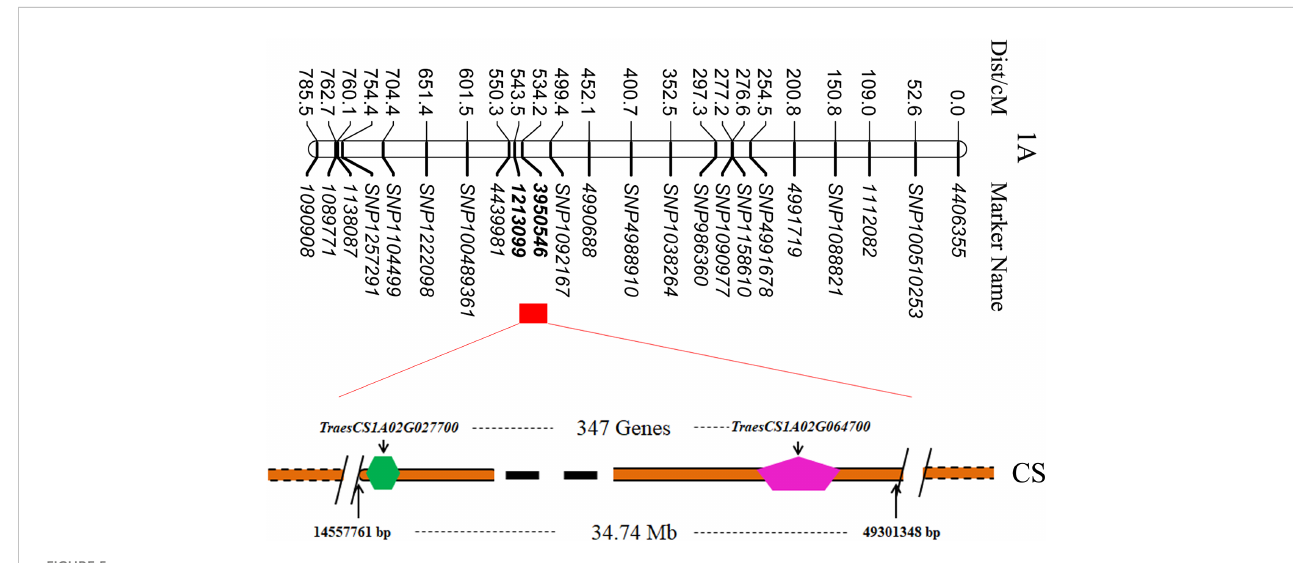
FIGURE 5 Possible physical segments of candidate genes on 1A chromosome. CS, Chinese